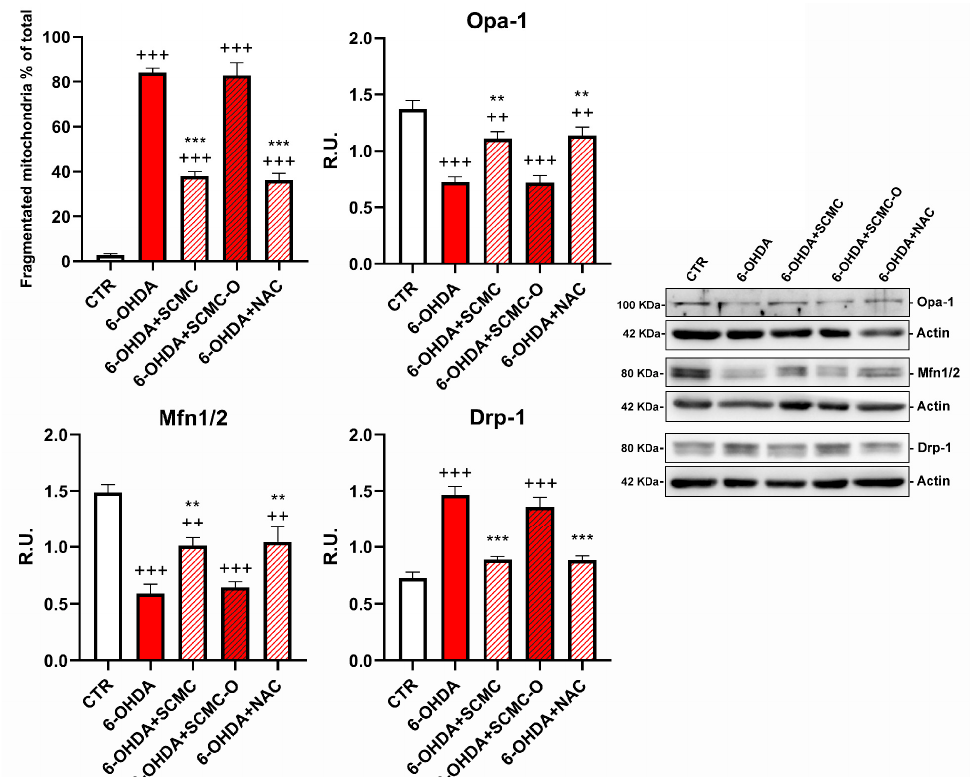
Figure 7. DAPI, Mitotracker deep red. The masks generated by ImageJ representative images are reported. In the red circle, the zoom in is reported to better appreciate the mitochondrial morphology. WB analyses for fission and fusion pathways. A representative WB figure is shown. Data are mean ± SD of three different experiments. *** p < 0.0001, ** p < 0.005 vs. 6-OHDA; +++ p < 0.0001; ++ p < 0.005 vs. CTR.